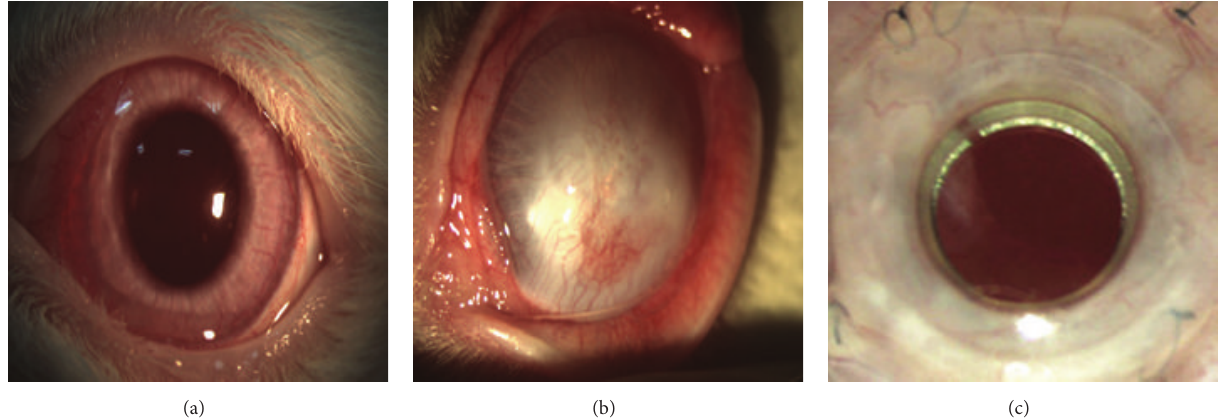
Figure 1: Slit-lamp appearance of anterior segment of the rabbit eyes before alkali burn (a), three months after alkali burn (b), and after implantation of Boston Type 1 keratoprosthesis (KPro), with the retroprosthetic membranes developed (c).